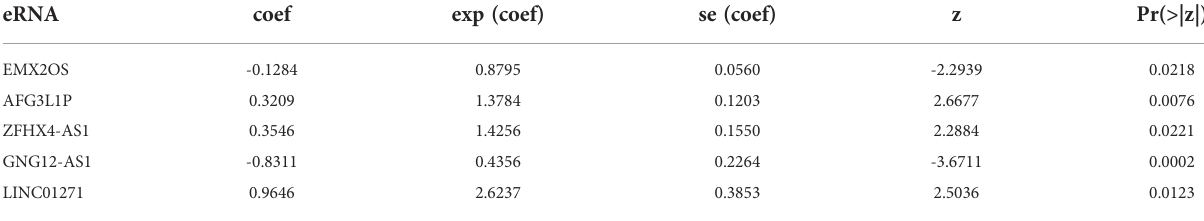
TABLE 1 Multivariate Cox regression analysis to identify prognosis-related eRNAs. eRNA coef exp (coef) se (coef)